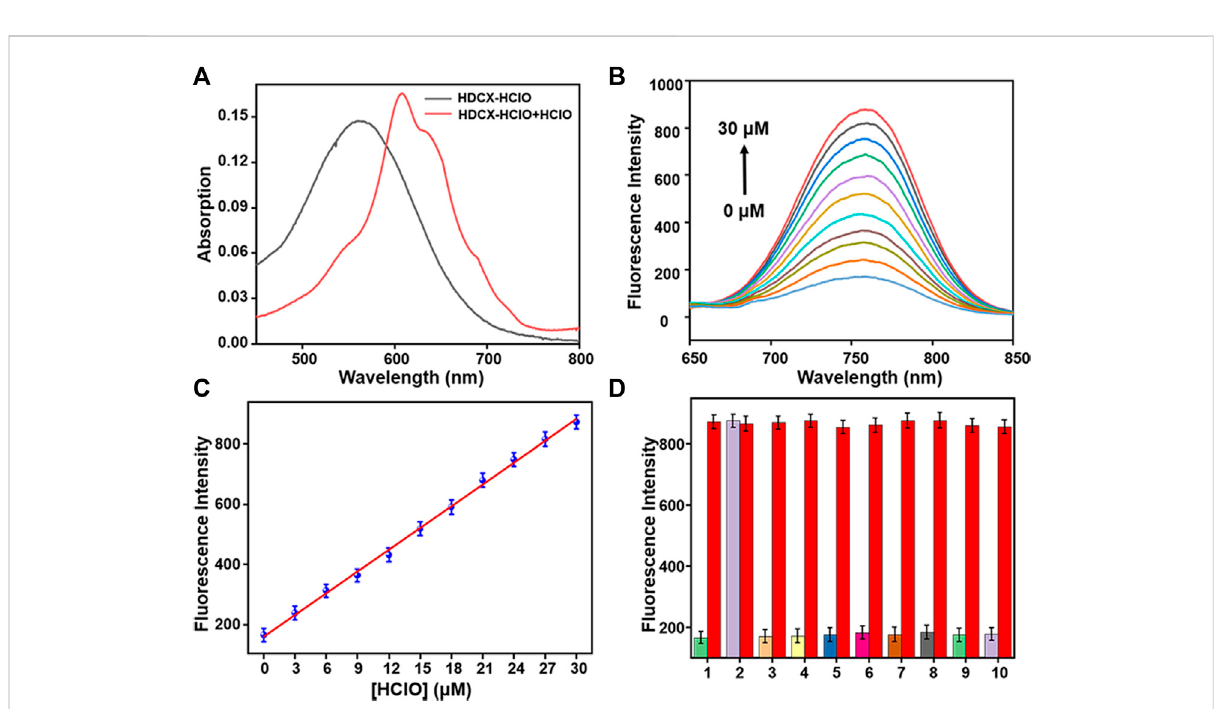
FIGURE 3 (A) Absorption spectra of HDCX-HClO (10 μ M) in presence or absence HClO (30 μ M). (B) Fluorescence spectra of HDCX-HClO toward various levelsofHClO(0 – 30 μ M). (C) ProbeHDCX-HClOversusHClOconcentrations. (D) FluorescenceintensityofHDCX-HClO(10 μ M)forotheranalytes: 1.blank;2.HClO;3.NO 2 − ;4. · OH;5. t BuOO . ;6.ONOO − ;7.NO;8.H 2 O 2 ;9.HNO;10.O 2 · - .ThespectrumwasobtainedinPBSsolutioncontaining40% DMSO (10 mM, pH 7.4) at room temperature. λ ex = 590